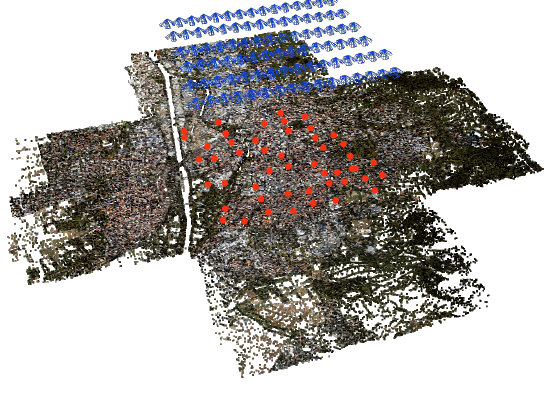
Figure 3. Real data used for the experiment. Cameras are represented by blue pyramids, control points are displayed as red dots (best viewed in